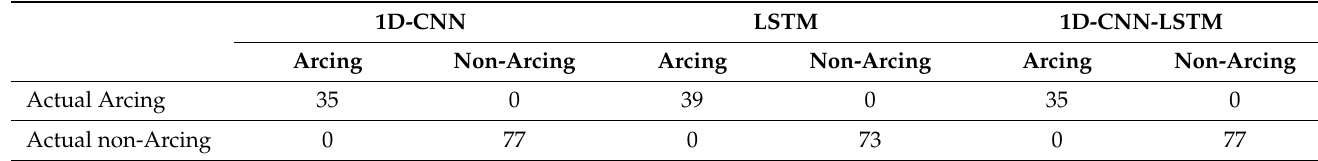
Table 8. Training Phase Output Matrix: Frequency Domain Arcing Fault Classification.